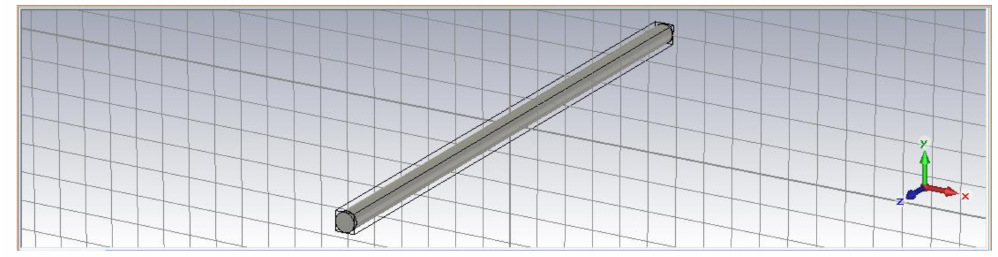
Figure 2. Screen shot of the coaxial cable simulated with